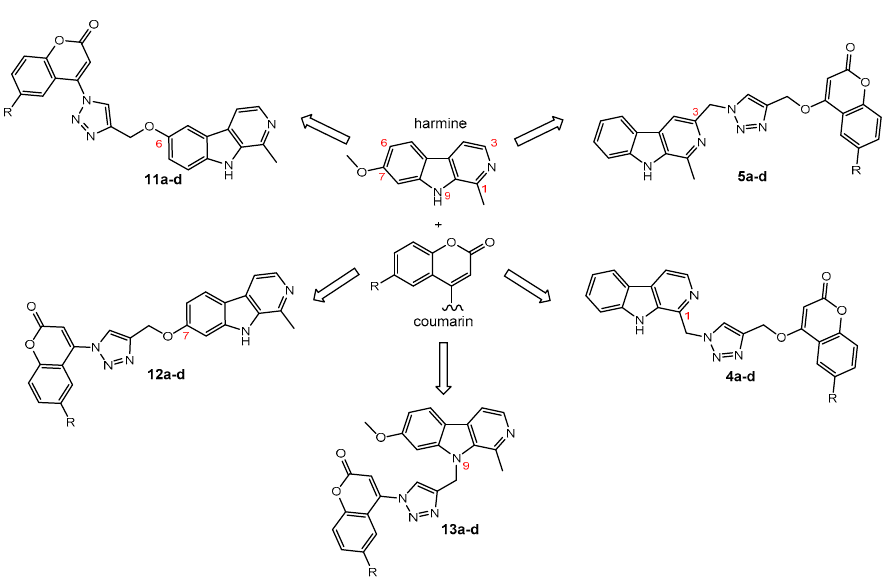
Figure 2. Novel harmirins—harmine–coumarin hybrids.